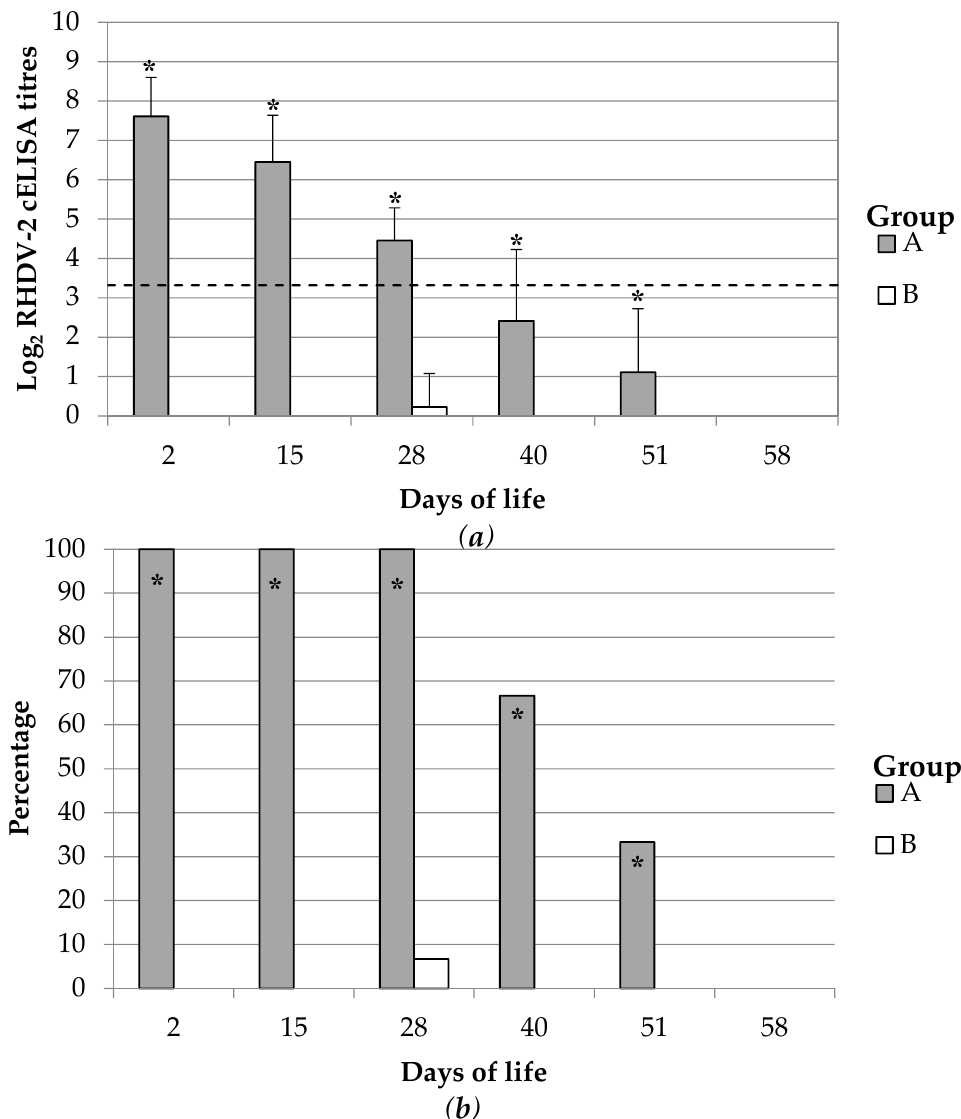
Figure 3. Duration of the maternal antibody immunity against RHDV-2 in rabbit kittens. Results are represented as ( a ) average and standard deviation of Log2 cELISA titres and ( b ) as percentage of positive rabbits. Rabbit kittens were born from breeding does vaccinated with either ERAVAC ® (Group A) or inoculated with PBS (Group B). The slashed line indicates the cut-off of the assay (3.32 Log 2 cELISA titre). Asterisks (*) indicate statistically significant differences between groups (( a ) Mann- Whitney U test, p < 0.05; ( b ) Chi-square or Fisher test, p < 0.05).